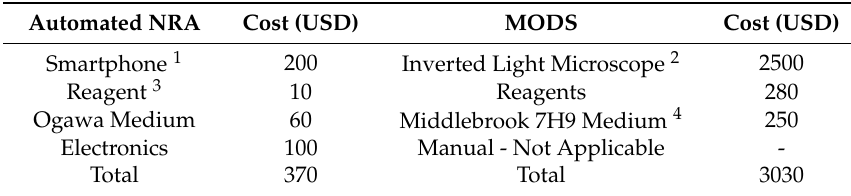
Table 2. Cost comparison between the proposed method and the MODS. Automated NRA Cost (USD) MODS Cost (USD) Smartphone 1 200 Inverted Light Microscope